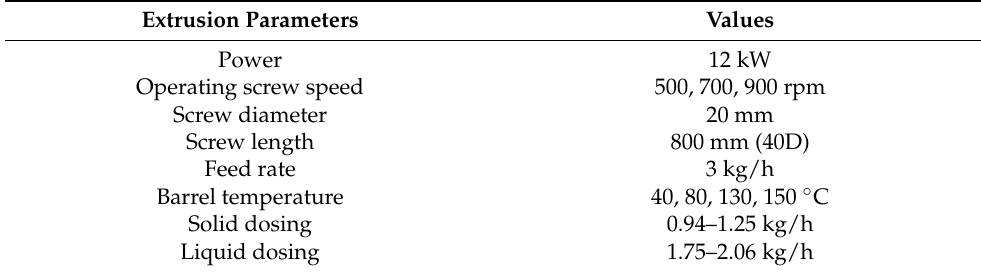
Table 1. Operational extruder parameters used in the